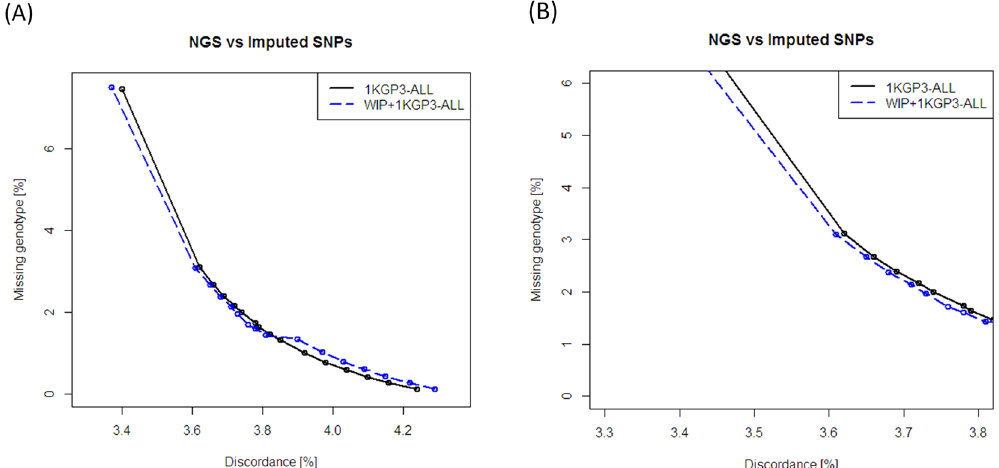
Figure 3. Validation of imputation performance using genotypes from targeted next-generation sequencing. The imputed genotypes in Affy6.0 data on 823 individuals generated using different panels were compared with the genotypes at 18979 common SNPs from targeted NGS of 3.57 Mb region. The imputation performance is illustrated by the percentage discordance (X-axis) plotted against percentage missing genotypes (Y-axis) for the SNPs common to the imputed and NGS genotype datasets. The figure shows the ( A ) full range of results corresponding to the probability thresholds ranging from 0.33 to 1.00 and ( B ) magnified results for probability thresholds near 0.90 and above for better comparison. 1KGP3-ALL, The 1000 Genomes phase 3 reference panel; WIP, Western-Indian reference panel; WIP + 1KGP3-ALL, merged panel of WIP and 1KGP3-ALL; NGS, next generation sequencing; SNPs, single nucleotide